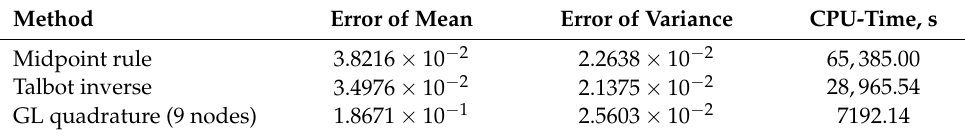
Figure 6. Expectation and variance of the numerical solution for the random hyperbolic PDE (25) with ϕ ∼ N ( 9,0.5 ) , b ( x ) = − e x , c ∼ Beta ( 2, 5 ) , performed by using the Monte-Carlo method with N Table 6. Comparison of various methods of numerical integration for Example 4, N MC =